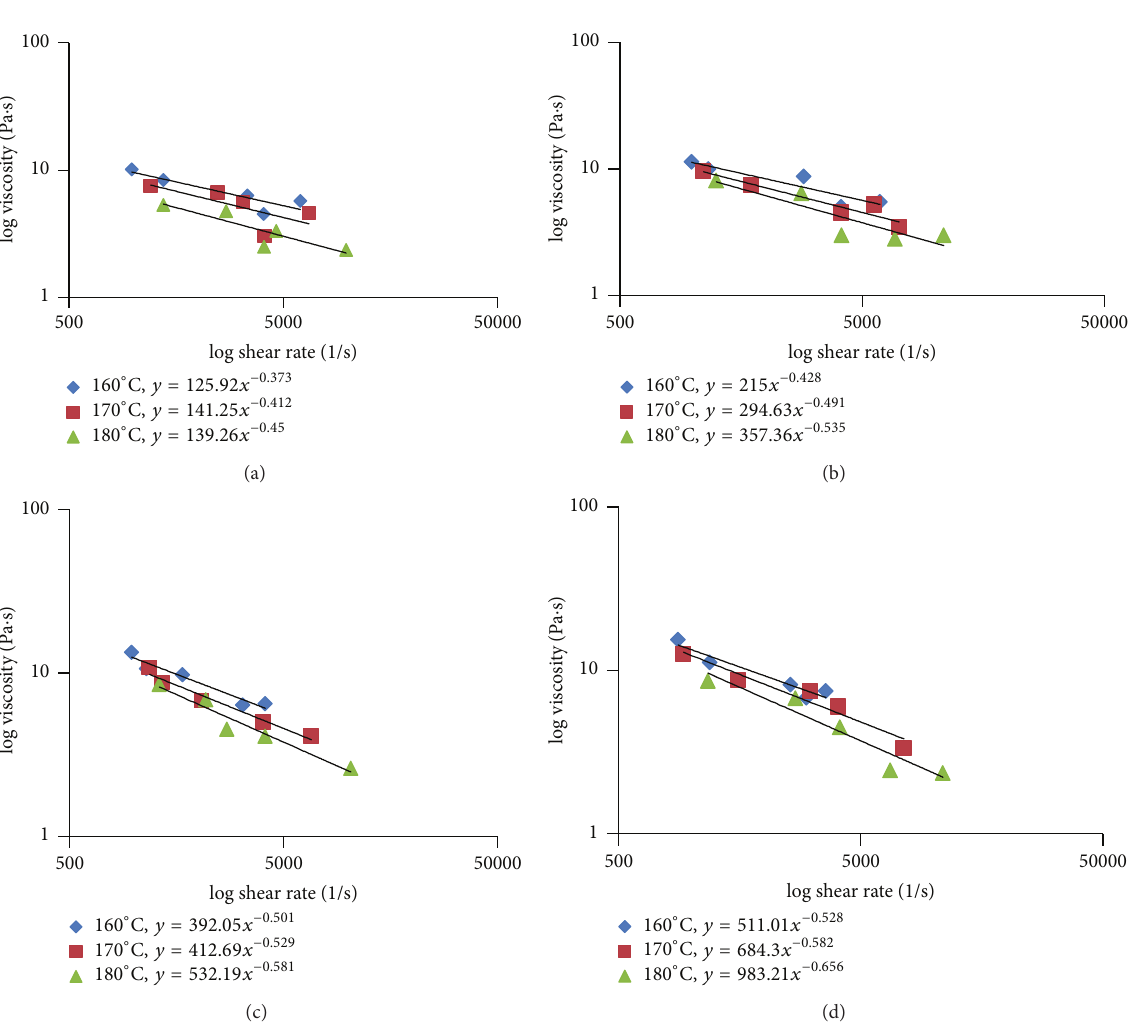
Figure 8: Viscosity results for (a) P25/75-61, (b) P25/75-64, (c) P25/75-67, and (d) P25/75-70